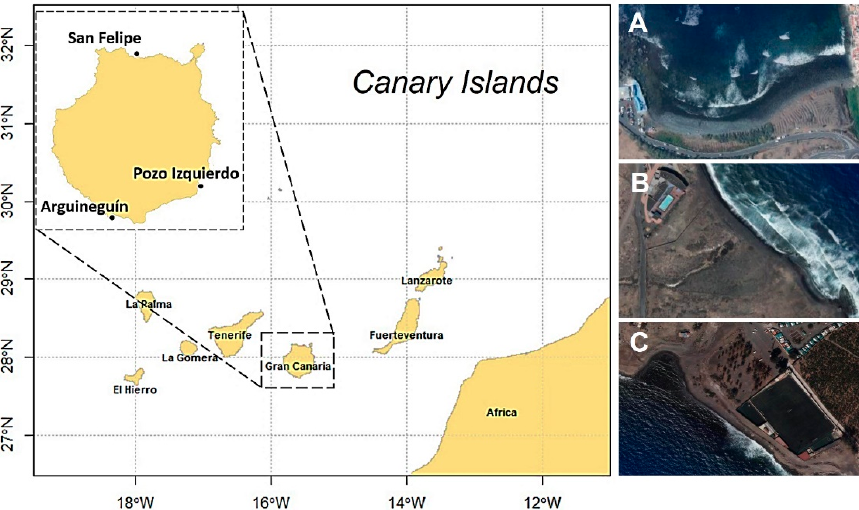
Figure 2. Location of the three sampled areas from Gran Canaria coast (Canary Islands, Spain). ( A ): San Felipe (north), ( B ): Pozo Izquierdo (east), ( C ): Arguineguín (south). Source ( A – C ): GRAFCAN, S.A. Canary Islands Government (2023).